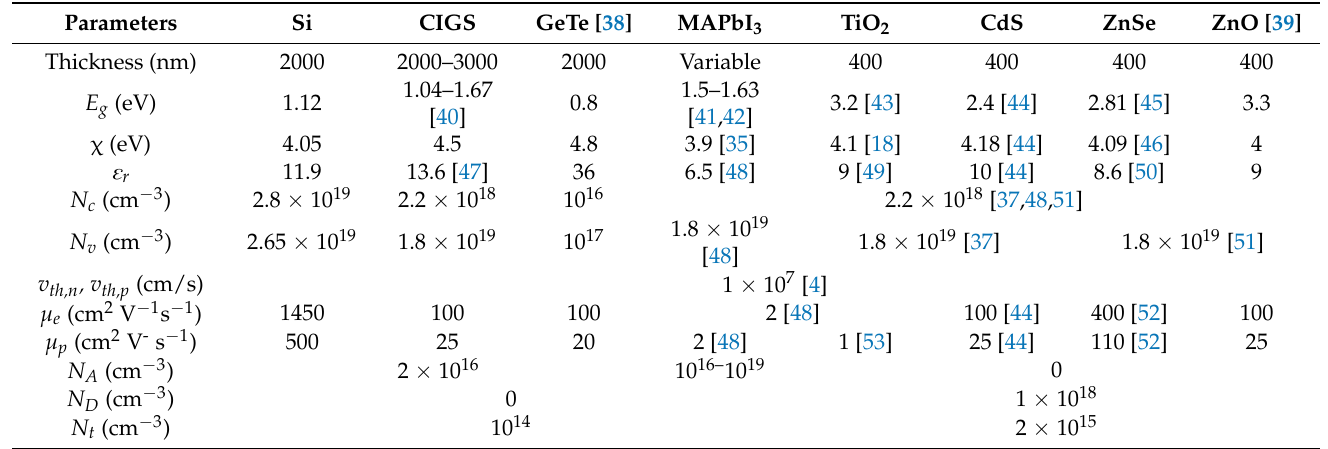
Table 2. Material parameters of the proposed tandem solar